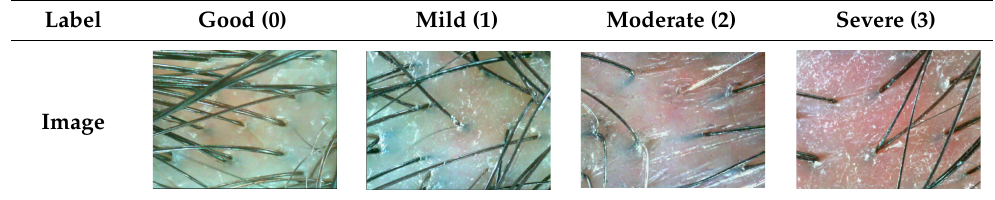
Table 3. Example image for each label.